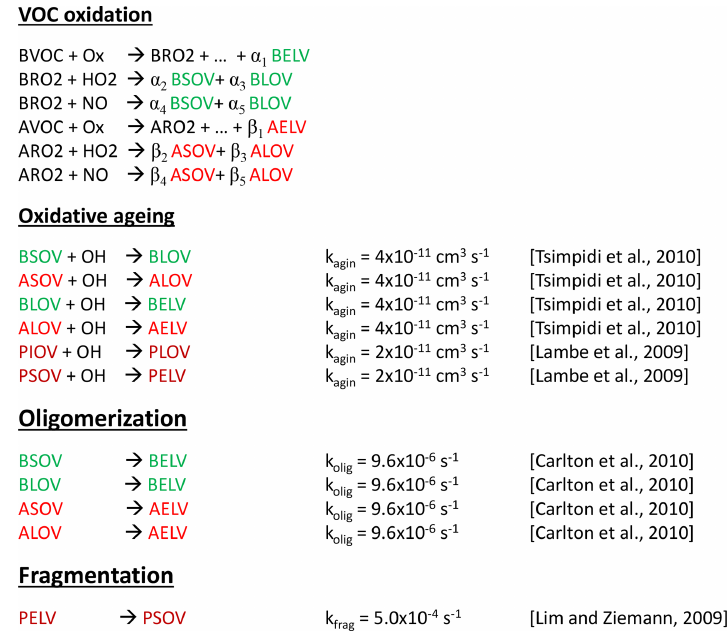
Figure 7. Chemical reactions involved in SOA formation. BRO2 and ARO2 stand for all the peroxy radicals of the respective biogenic or aromatic VOCs. The molar stoichiometric yields α 1 , ... , α 5 , and β 1 , ..., β 5 represents the formation yields of SOA precursors in the gas-phase reaction of biogenic and aromatic VOCs, respectively. Oligomerization and fragmentation reactions are approximated with first- order rate constants (Tsimpidi et al., 2010; Lambe et al., 2009; Carlton et al., 2010; Lim and Ziemann, 2009). The nine lumped organics are BSOV (biogenic semi-volatile compound), BLOV (biogenic low-volatility compound), BELV (biogenic extremely low-volatility com- pound), ASOV (aromatic semi-volatile compound), ALOV (aromatic low-volatility compound), AELV (aromatic extremely low-volatility compound), PIOV (primary intermediate-volatility compound), PSOV (primary semi-volatile compound), and PELV (primary extremely low-volatility